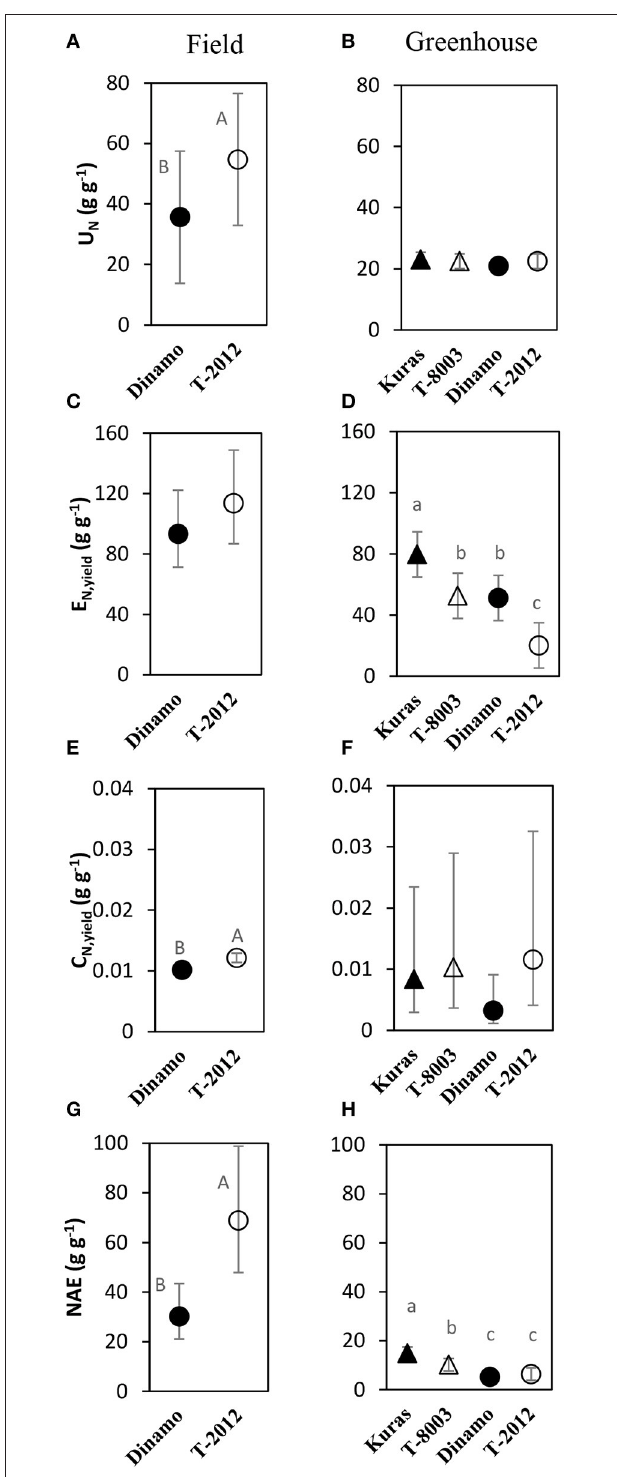
FIGURE 3 | Means of N accumulation efficiency and its components in the field experiment ( A,C,E,G ; 2015) and greenhouse ( B,D,F,H ; 2014). U N = N uptake efficiency, E N , yield = yield specific N efficiency, C N , yield = yield N concentration, NAE = N accumulation efficiency. Two GM lines (“T-8003” and